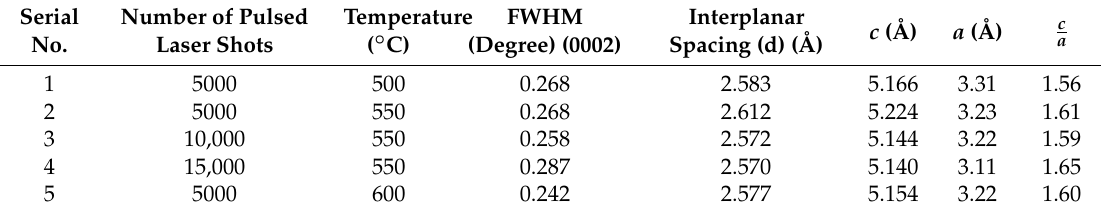
Table 2. XRD Peak positions of (0002) plane of ZnO nanorods deposited on Si substrate.